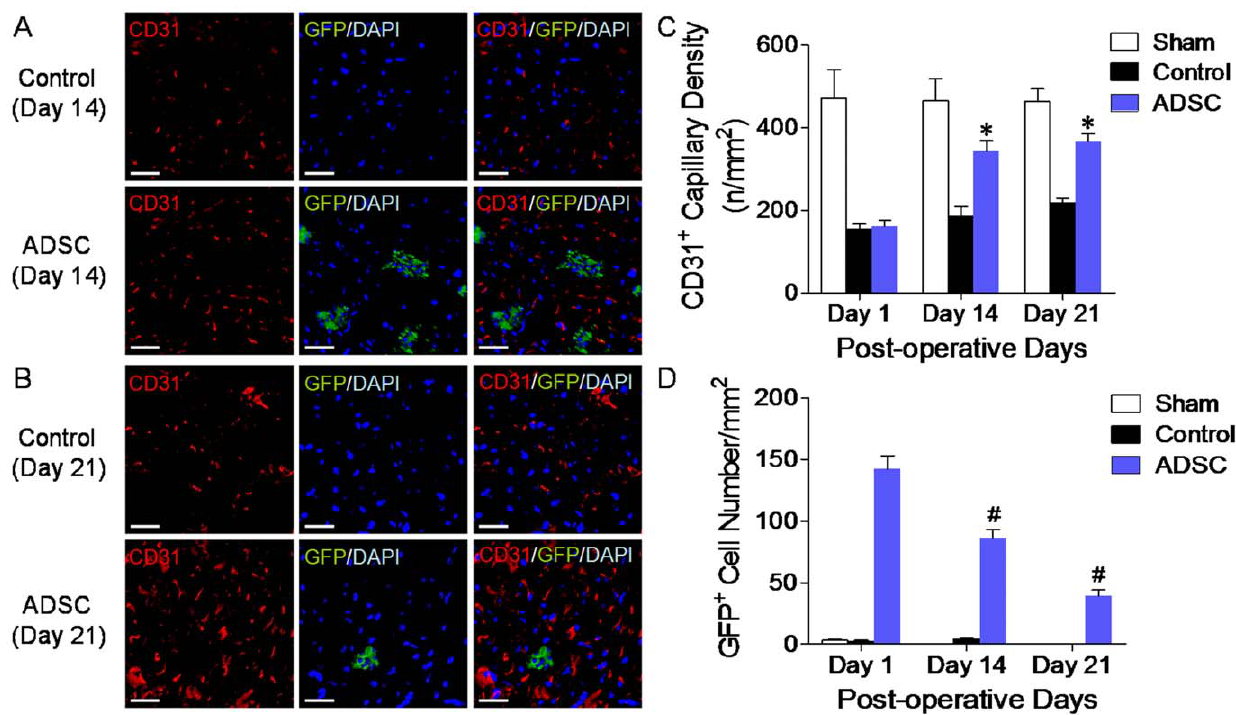
Figure 6. Immunofluorescence assessment of mADSC engraftment and angiogenesis. Confocal microscopy of ischemic gastrocnemius muscle tissue sections triply stained with GFP (green), endothelial marker CD31 (PECAM-1, red) and 4 9 ,6-diamidino-2-phenylindole (DAPI, blue) visualized the para-vascular survival of mADSCs Fluc + GFP + ( a and b ). Quantitative analysis of CD31 + blood vessels ( c ) and GFP + cells ( d ) within the same- sized regions. n=20 random fields. Scale bars represent 50 m m. Error bars: mean 6 SD. * P , 0.001 vs. Control, # P , 0.001 vs. Day 1 within ADSC